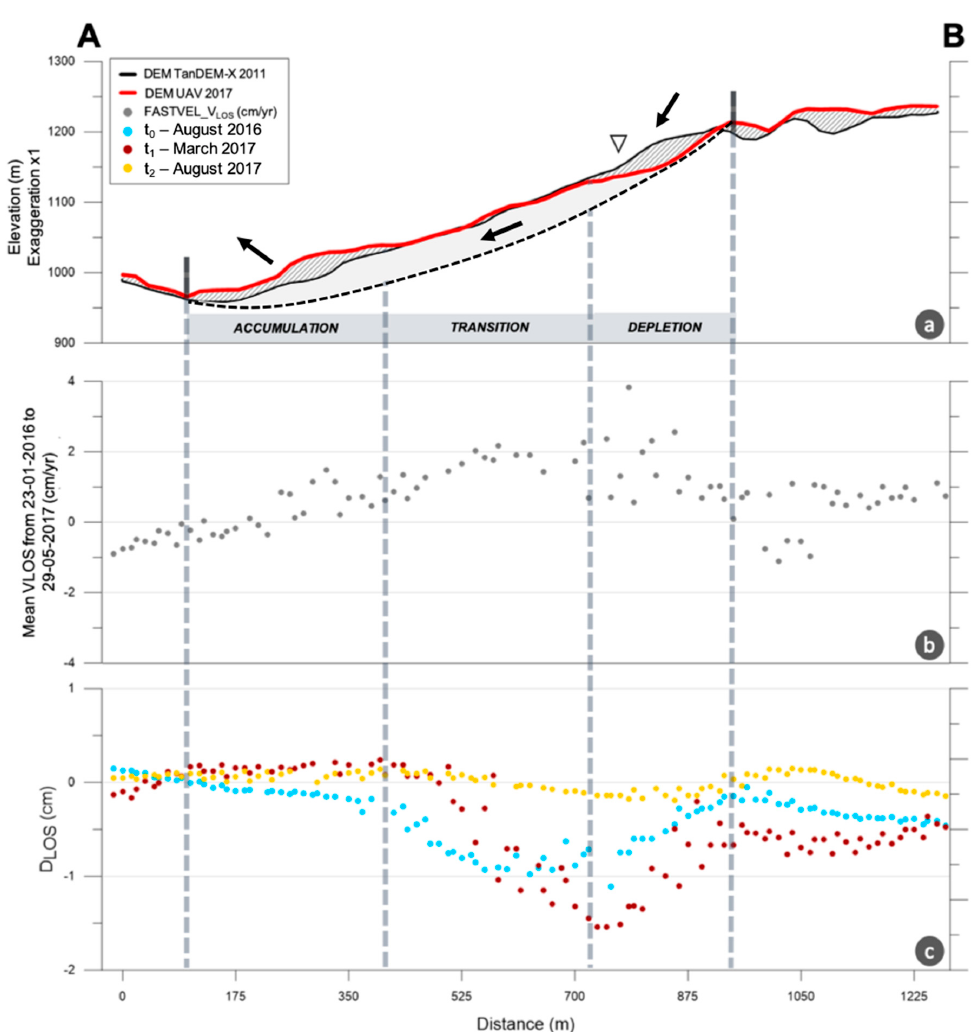
Figure 10. ( a ) A-B profiles of the altitudes (expressed in m, no vertical exaggeration) of the TanDEM-X DEM (2011, in black) and of the UAV DEM (2017, in red). The two marks in gray represent the limits of the Koytash landslide; ( b , c ) Extraction of the V LOS (in cm / year) and D LOS (in cm) values for each station on the three A-B profiles separated by 40 m (see Figure 9). The V LOS were calculated for a period between 23 January 2016 and 29 May 2017. The areas of accumulation, transition, and depletion are highlighted and the inverted triangle represents the major peak of displacement